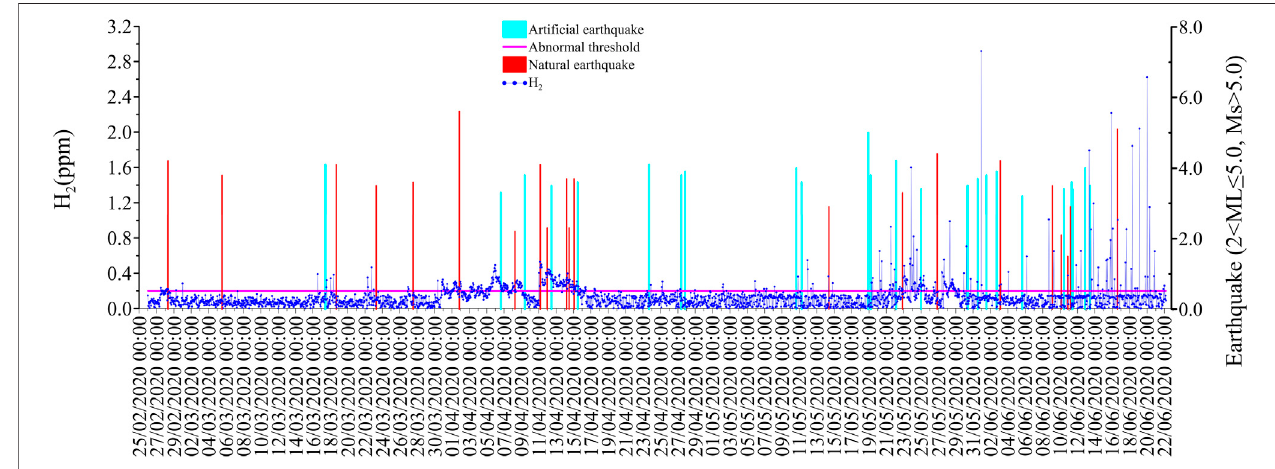
FIGURE 4 | Temporal variations of H 2 concentration in bubbling gas.